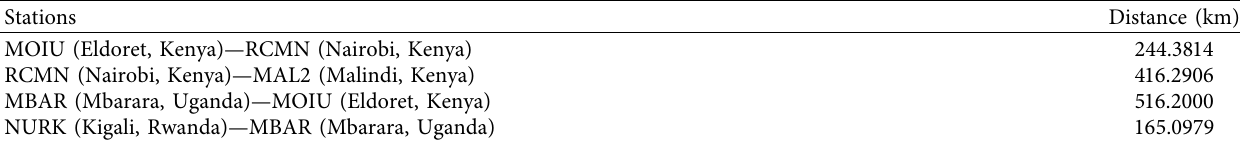
Table 2: Distances between stations along similar or close